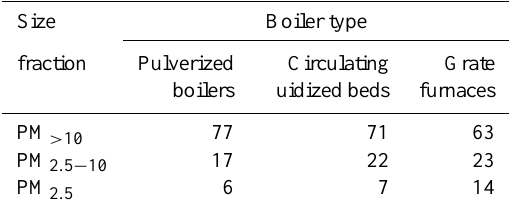
from the IPCC guidelines (IPCC, 2006). The data source of the coal heating value is presented in Sect.